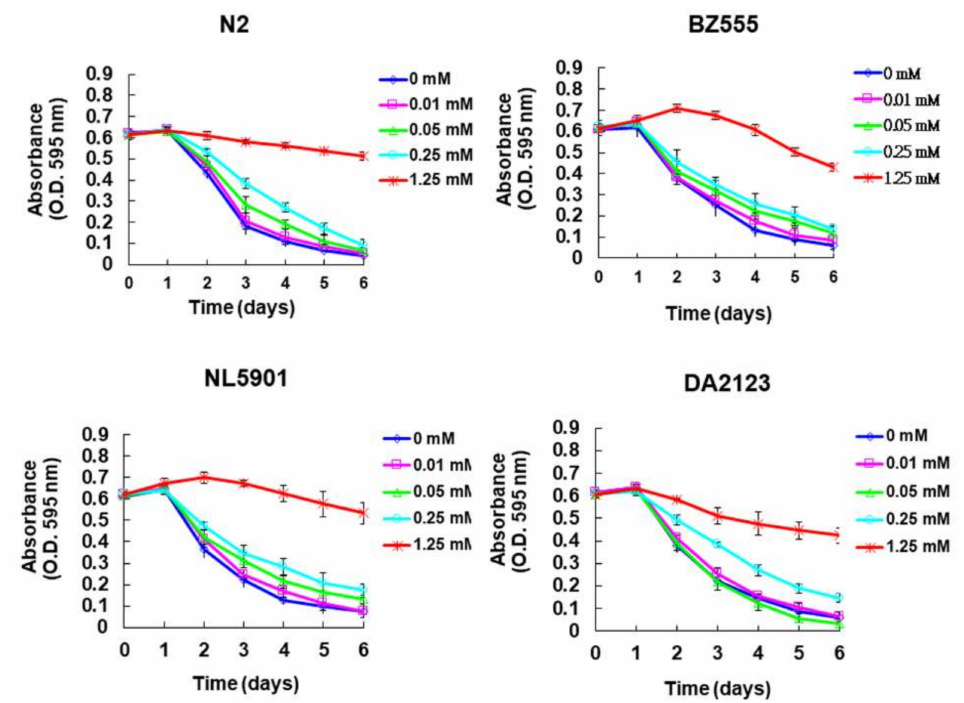
Figure 2. Evaluation of the toxicity of peiminine (PMN) in worms by food clearance test. In 96-well plates, L1 stage worms of four strain were cultured on OP50 E. coli (OD A 595 = 0.6) feeding S-medium containing four concentrations of PMN, respectively. Cultivation was continued for 6 days, and the OD value of each group was measured and recorded